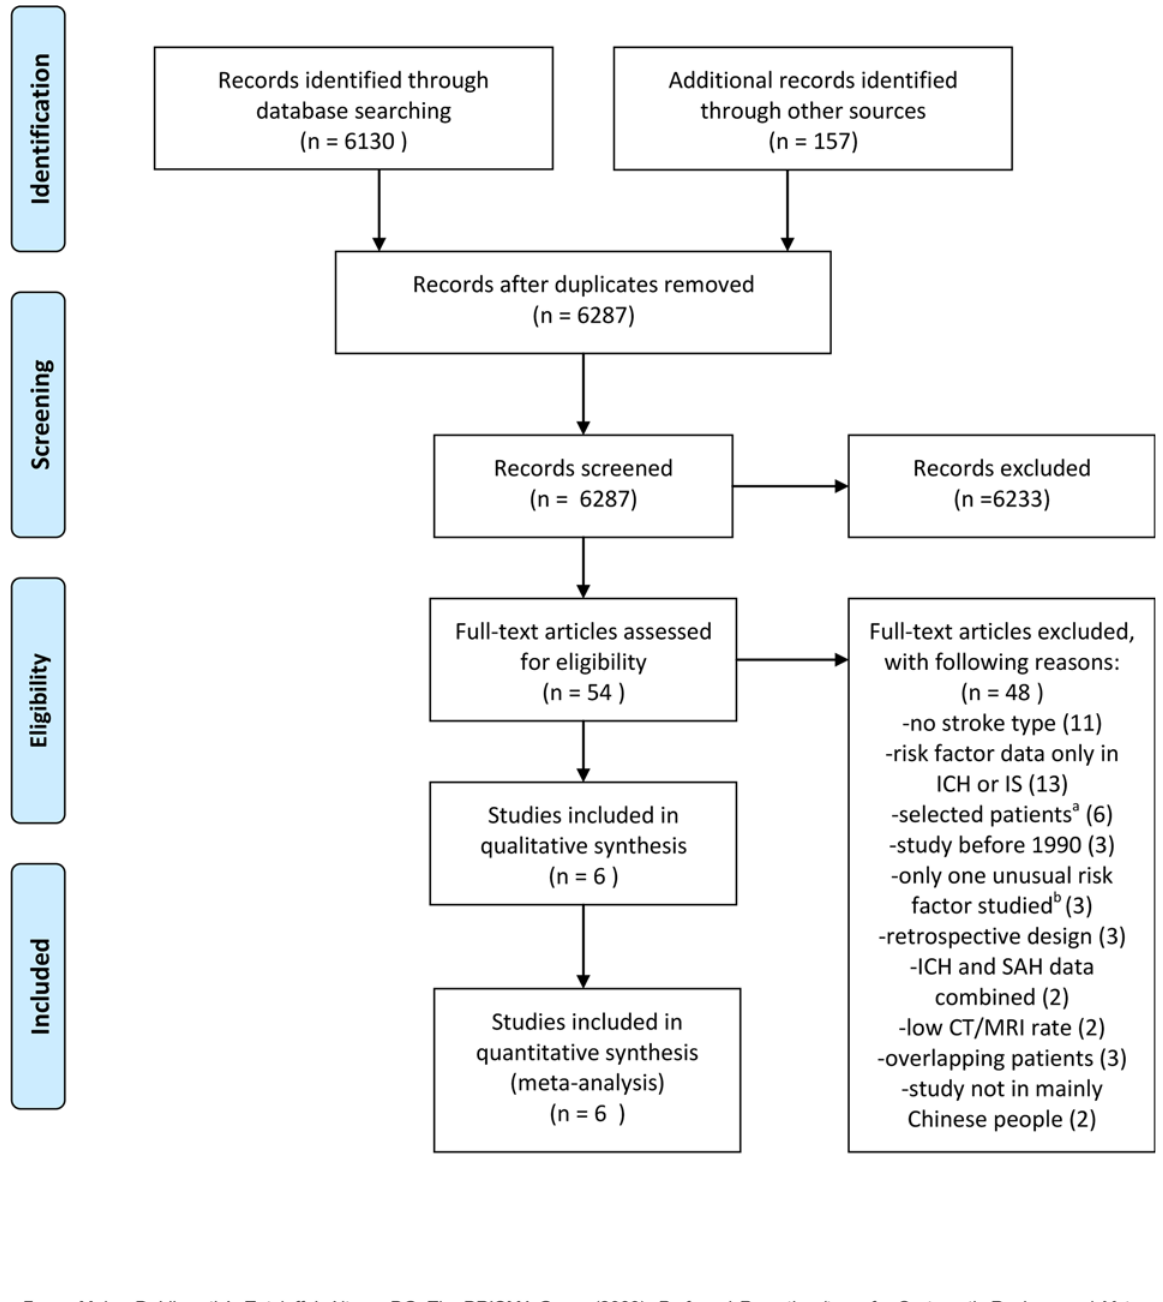
Fig 1. Selection of studies in Chinese populations. a. excluding patients with cardiogenic emboli; excluding patients with cardiogenic emboli, arteriovenous malformation, or using anticoagulants; excluding patients with other major illness (e.g., cancer, anemia); data only in men; data only in diabetes; data only in patients aged 35 – 64 years. b. weather, circadian variation of stroke onset, and dietary pattern.